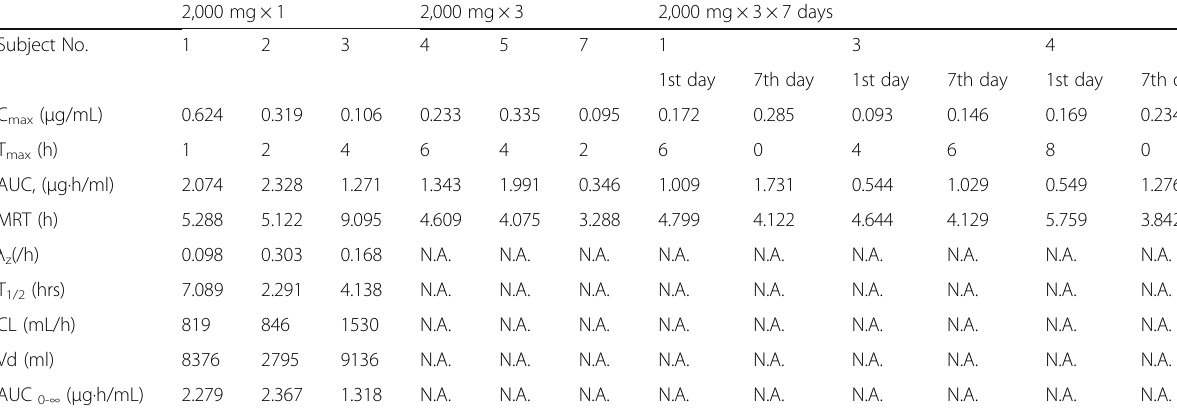
Table 2 Aceneuramic acid pharmacokinetic parameters in Trial-2 2,000 mg × 1